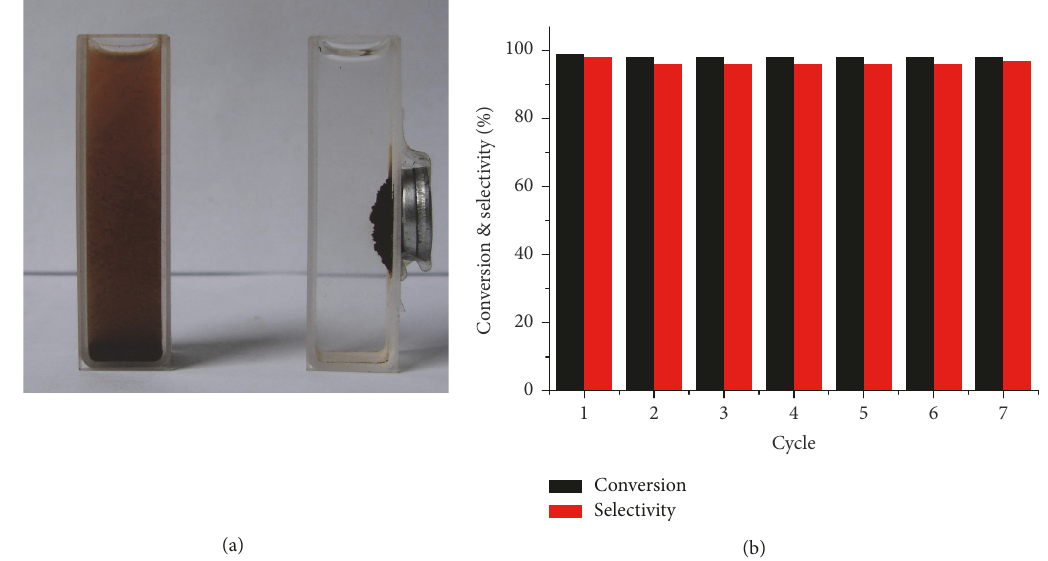
Figure3:(a)ImageforthemagneticseparationofthenanoparticlesintheMontanarioxidationofbenzylalcohol.(b)RecyclabilityofTEMPO supported on nanocomposite particles in the Montanari oxidation of benzyl